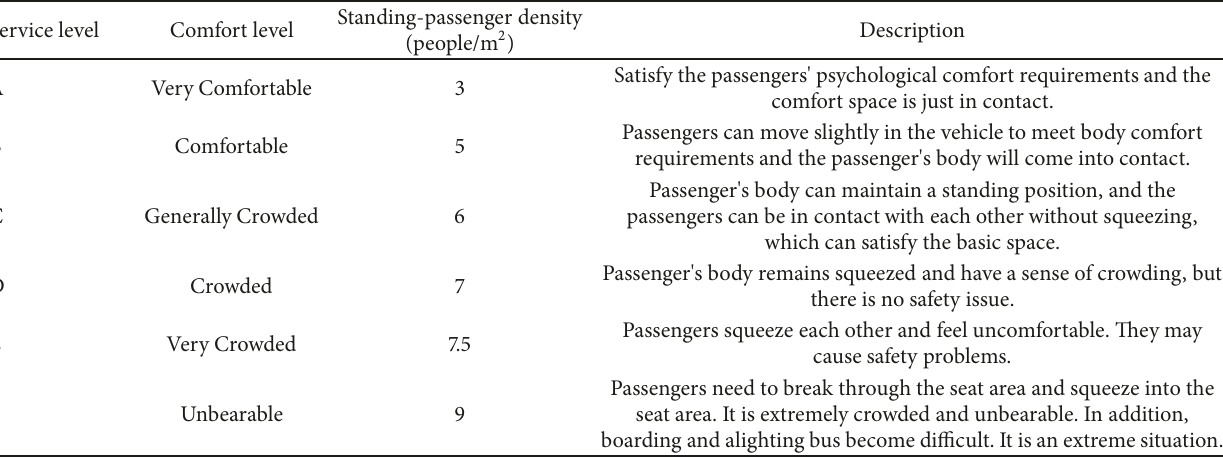
Table 1: Passenger standing density evaluation standards.